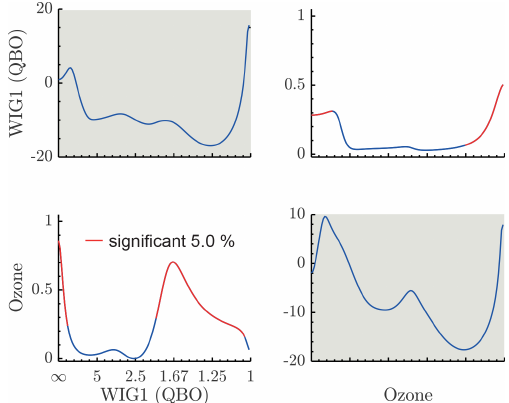
Figure 9. PDC analysis of the interaction of westward gravity modes and ozone at the slow timescale (periods given in years). Im- portant interactions are found on annual–biennial timescales and on the decadal timescale. Figure conventions are the same as in Fig.